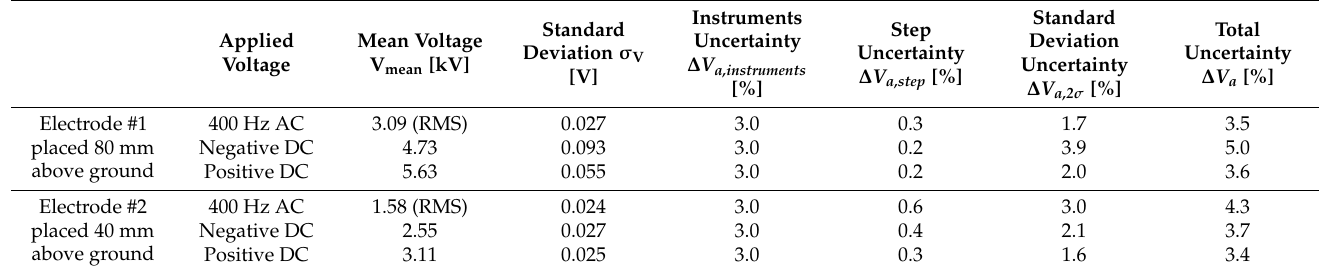
Table 3. Static pressure tests. Summary of experimental results at constant pressure when the voltage was increased at an approximate rate of 20